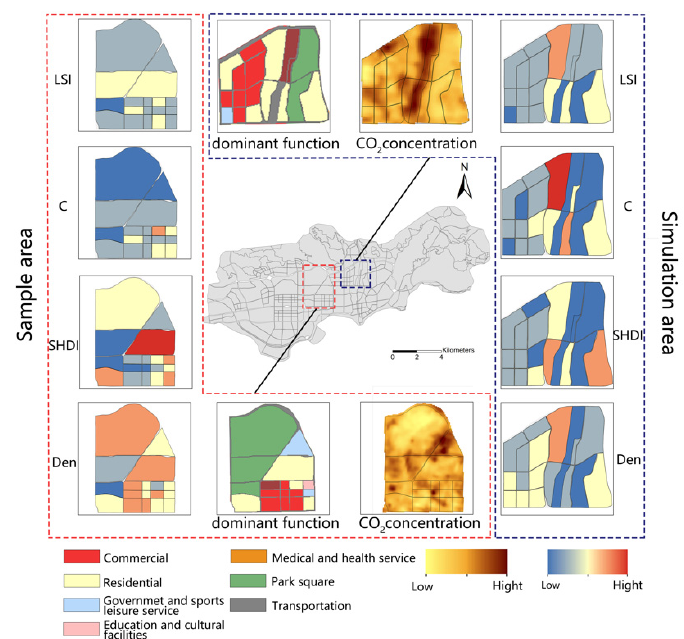
Figure 10. Current situation of landscape indices in sample area and simulation area.